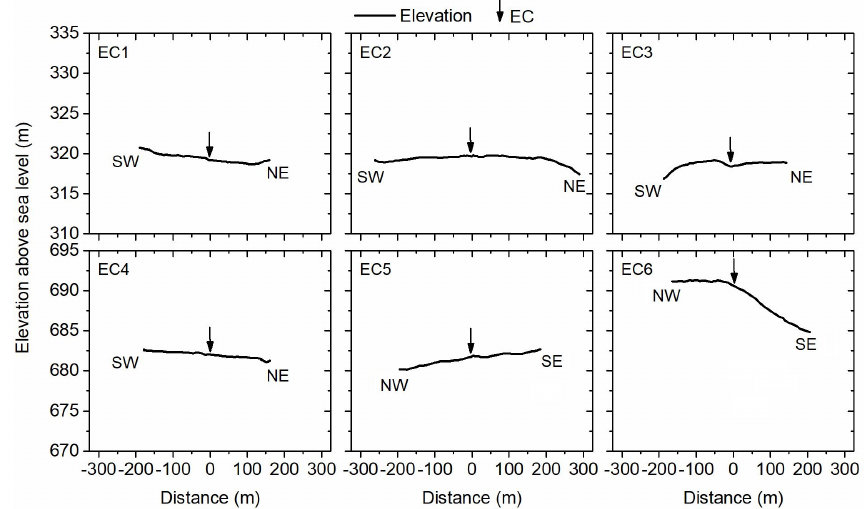
Figure 3. Elevations at EC sites along the dominant wind directions (see Figs. 1 and 3). Arrows present positions of EC